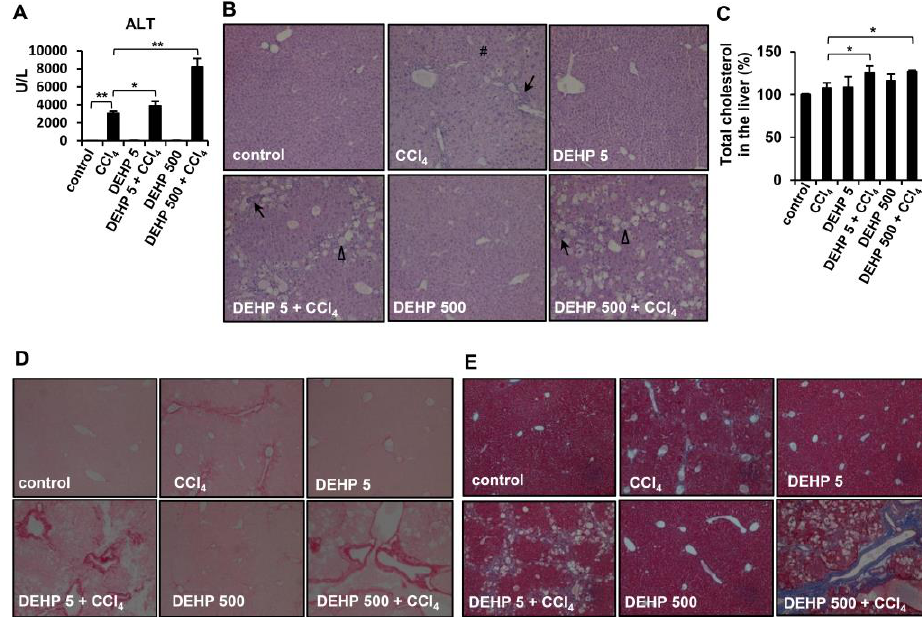
Figure 7. Effects of long-term, low-dose DEHP exposure in CCl 4 -treated mice. (A) Serum alanine aminotransferase (ALT) . (B) Hematoxylin and eosin ( H&E) staining of liver tissues Δ, fatty change #, perinuclear vacuoles ↑ , and inflammatory infiltration. (C) Hepatic cholesterol content. (D) Sirius red, and (E) Masson’s Trichrome staining of liver tissues. * p < 0.05; ** p < 0.01.